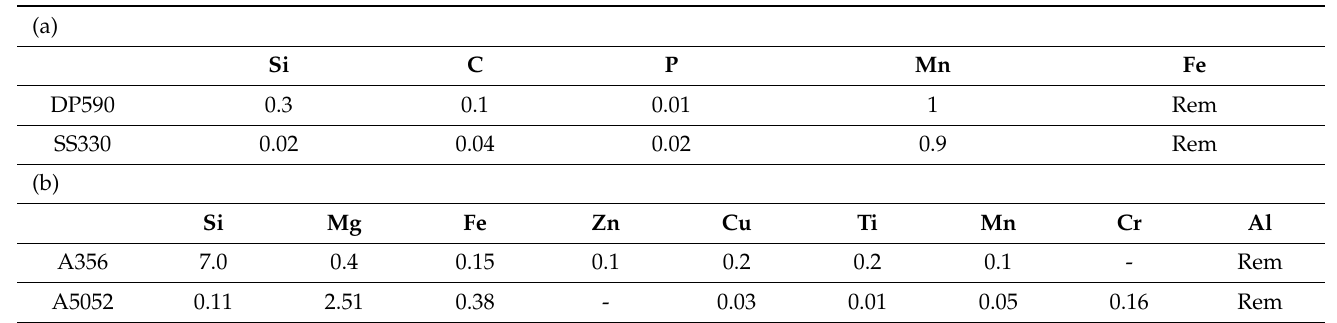
Table 1. Chemical compositions of the (a) DP590 and SS330 steels and (b) A356 and A5052 aluminum alloys used in this study (wt%).